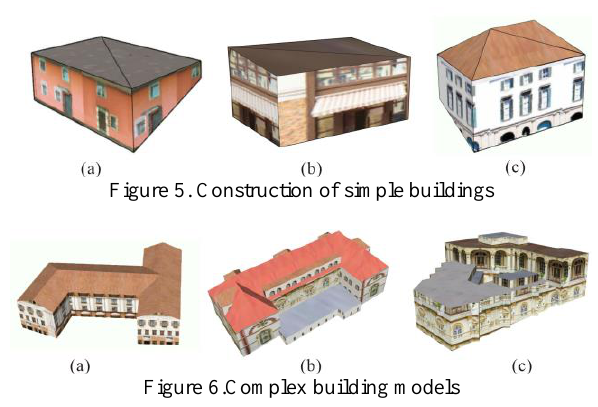
Figure 6.Complex building models